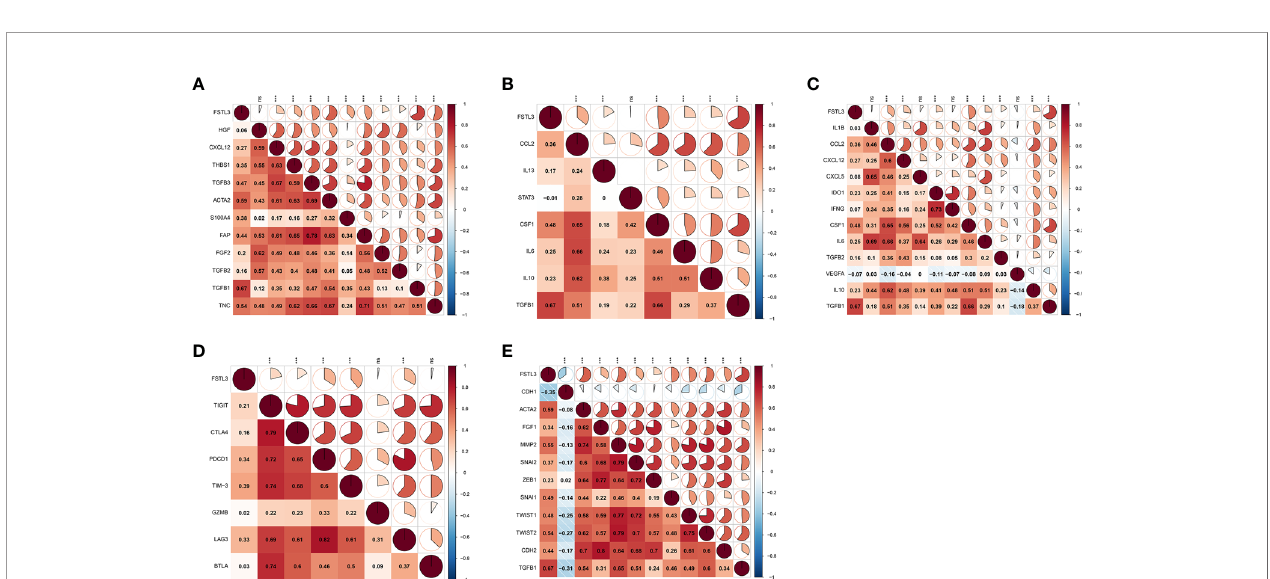
FIGURE 10 | Correlation Between FSTL3 and immune modulators in CRC. (A, B) FSTL3 is signi fi cantly positively correlated with CAF-associated (A) and M2-like macrophage (B) genes. (C) The majority of immunosuppressive factors were correlated with FSTL3 positively. (D) FSTL3 is positively correlated with many T cell exhaustion genes in CRC. (E) Almost all EMT-related marker genes, except CDH1 which is biomarker of epithelial cells, are positively correlated with FSTL3 expression. ns: non-signi fi cant; * P < 0.05, ** P < 0.01, *** P < 0.001.